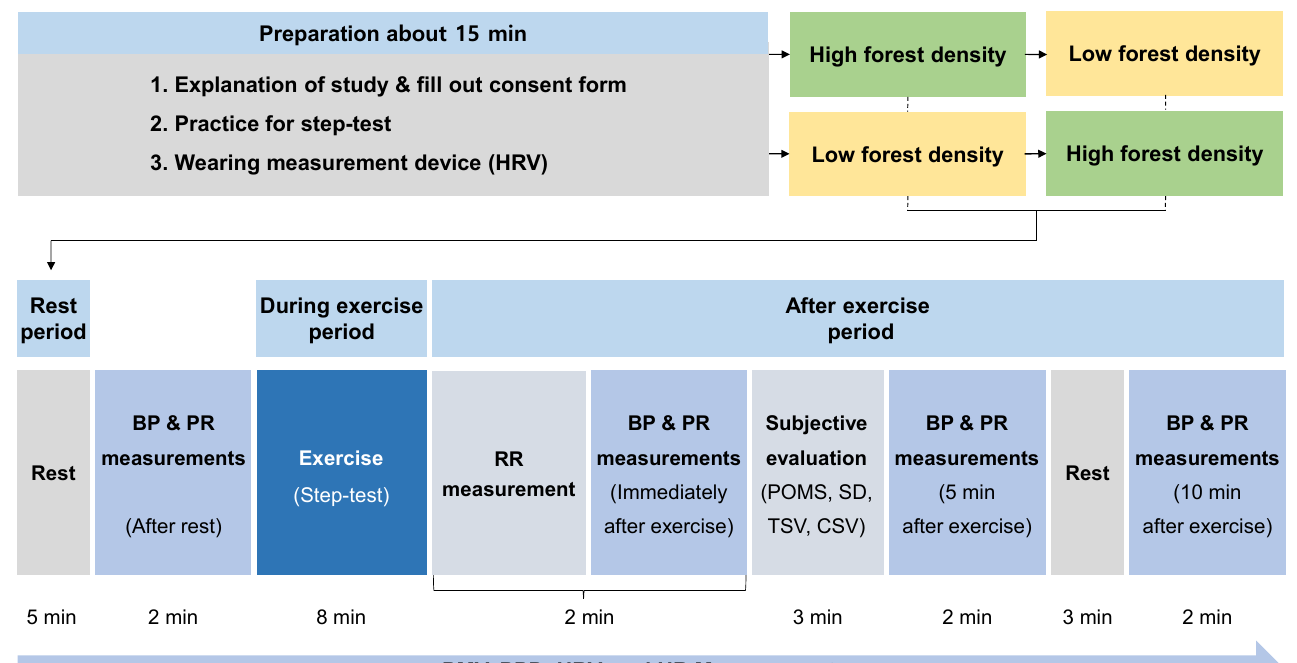
Figure 4. Experimental design. BP (blood pressure); CSV (comfort sensation vote); HRV (heart rate variability); PMV (predicted mean vote); POMS (profile of mood states); PPD (predicted percentage of dissatisfied); PR (pulse rate); RR (respiratory rate); SD (semantic differential); TSV (thermal sensation vote).